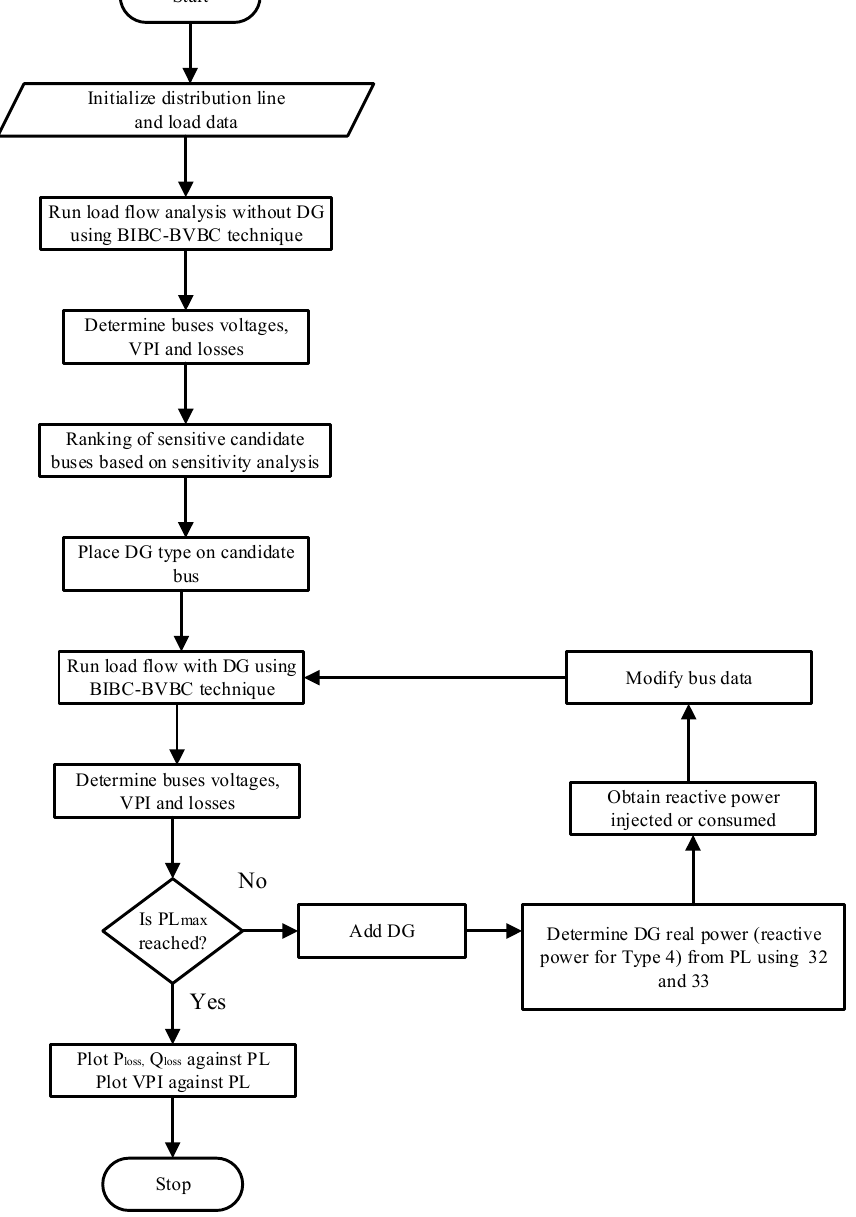
Figure 10. Flow chart to obtain the impact of DG types on Radial Distribution Network.